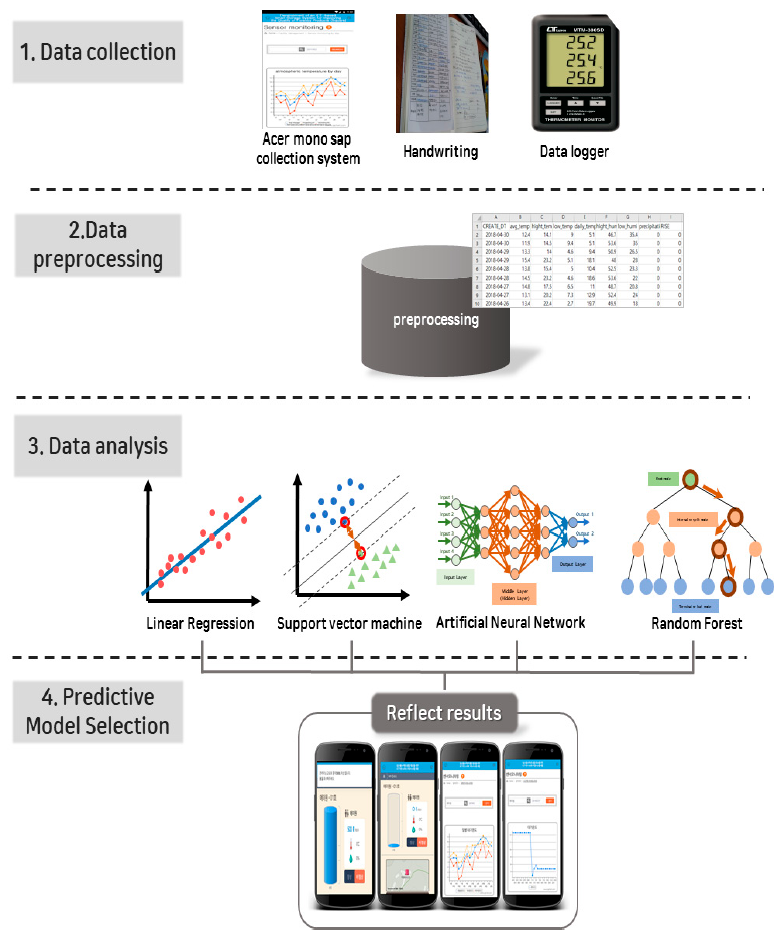
Figure 7. Flow chart of Acer mono sap data analysis.